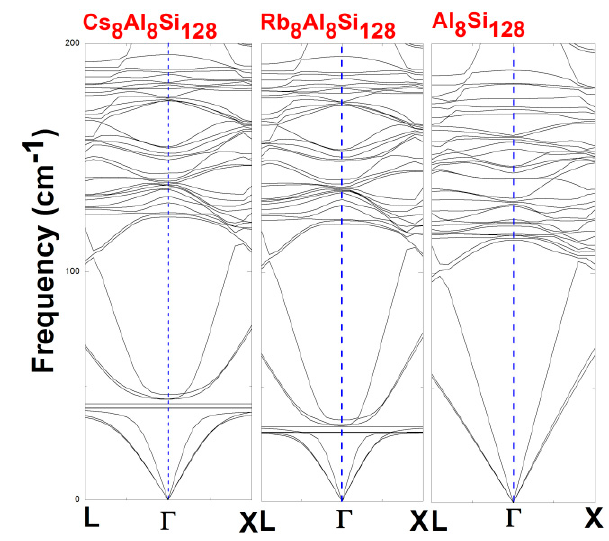
Figure 3. Predicted low-frequency vibration spectrum of Cs 8 Al 8 Si 128 ,Rb 8 Al 8 Si 128 and Al 8 Si 128 .